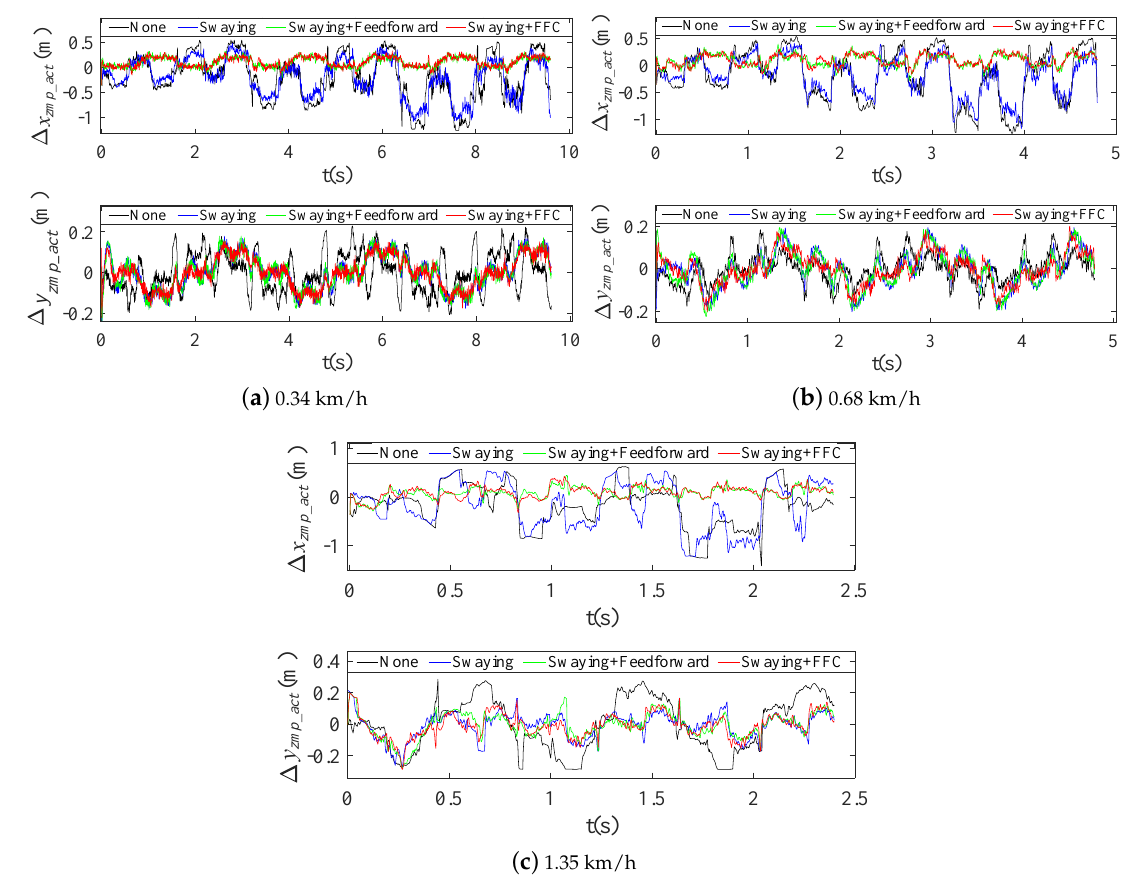
Figure 12. ZMP tracking errors at three different